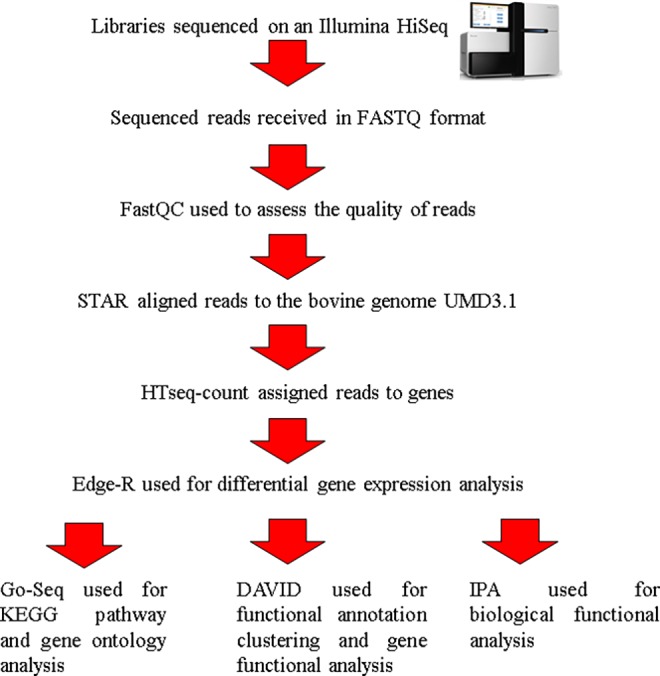
Illustration of the bioinformatic pipeline utilised for RNA-seq data analysis.Paired-end sequencing was performed on the Illumina HiSeq, FastQC was used to assess sequencing quality, reads were aligned to the bovine genome with Spliced Transcripts Alignment to a Reference (STAR), counts were assigned to genes with HTseq-count, Edge-R was used to calculate differential gene expression, Kyoto encyclopaedia of genes and genomes (KEGG) pathway and gene ontology analysis were performed in GoSeq, functional annotation clustering and gene functional analysis was performed with Database for Annotation, Visualization and Integrated Discovery (DAVID), biological functional analysis was performed with Ingenuity Pathway Analysis (IPA) downstream effects.